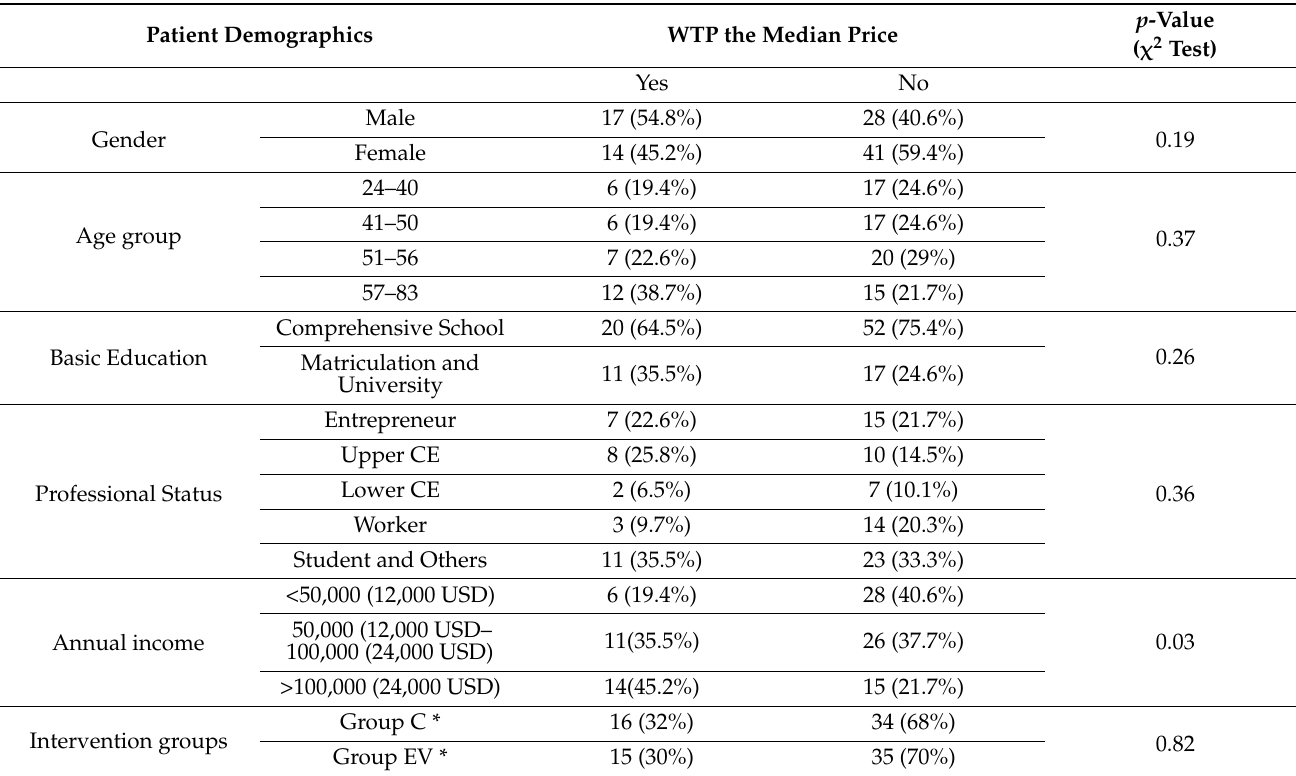
Table 2. Association of variables to willingness to pay the median price.